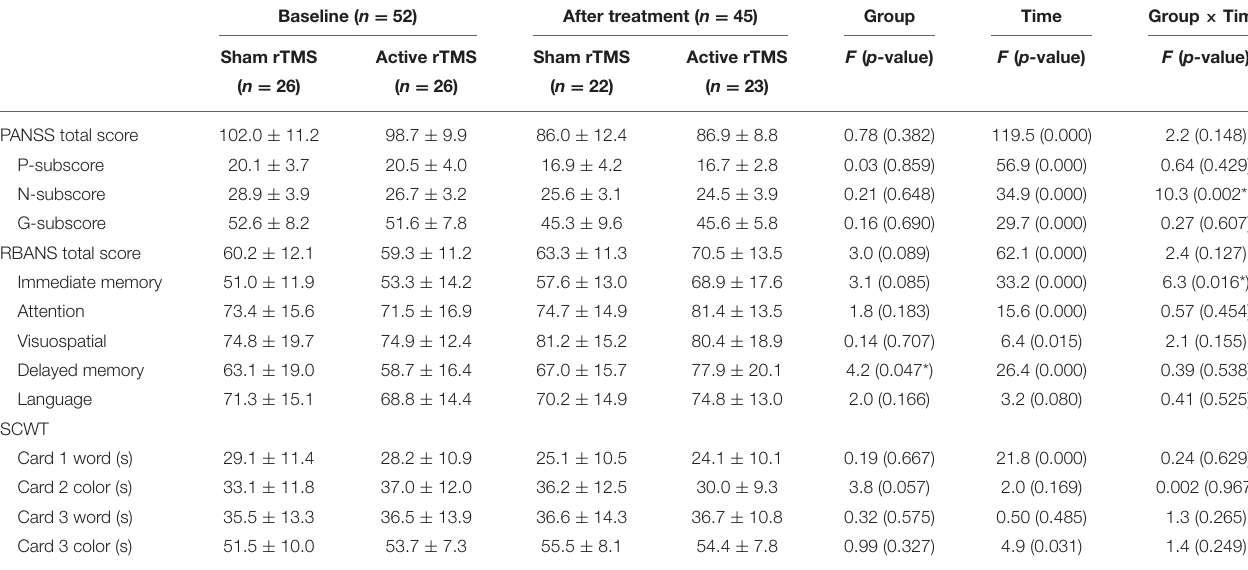
TABLE 2 | Primary and secondary outcome measures at the beginning and the end of 4 weeks of rTMS treatment. Baseline ( n = 52) After treatment ( n = 45) Group Time Group × Time Sham rTMS Active rTMS Sham rTMS Active rTMS F ( p- value) F ( p- value) F ( p- value)